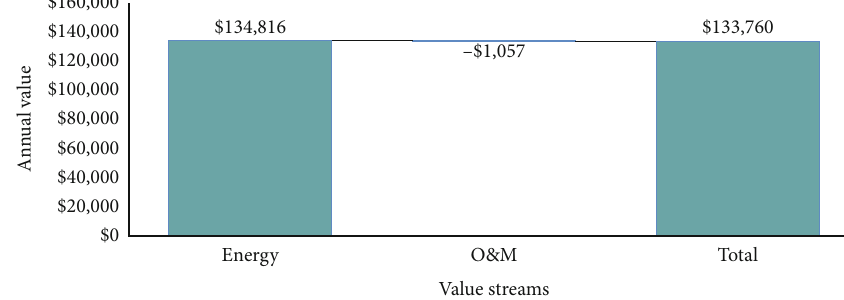
Figure 51: Categorized annual savings for the proposed system for Rwanda.